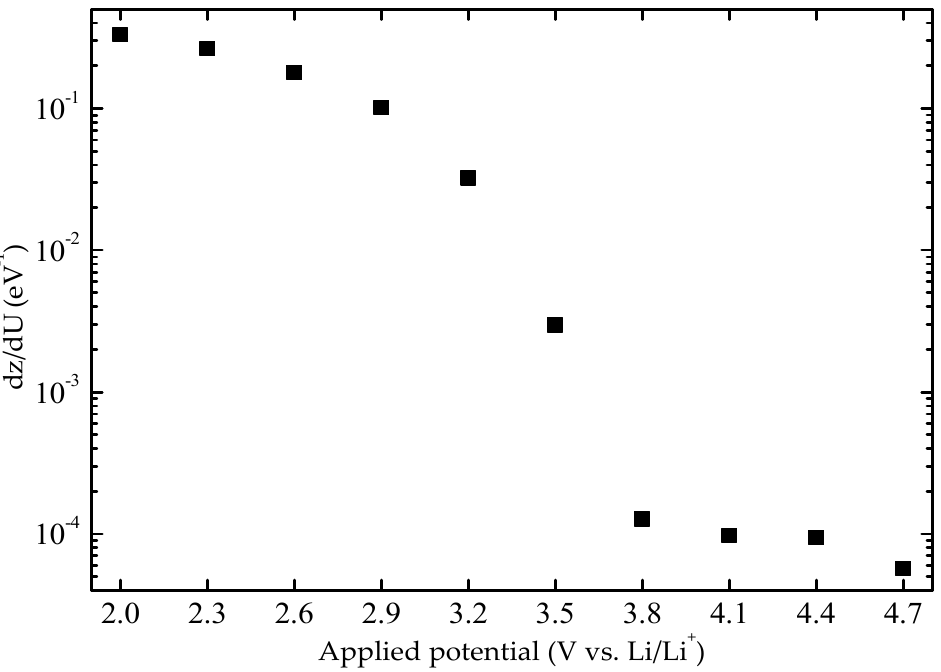
Figure 5. Charge capacity of inserted Li ions/electrons per unit potential and formula unit, denoted dz/dU , as a function of potential vs. Li/Li + for a ~300-nm-thick HWO x film measured in a Li + -containing electrolyte.